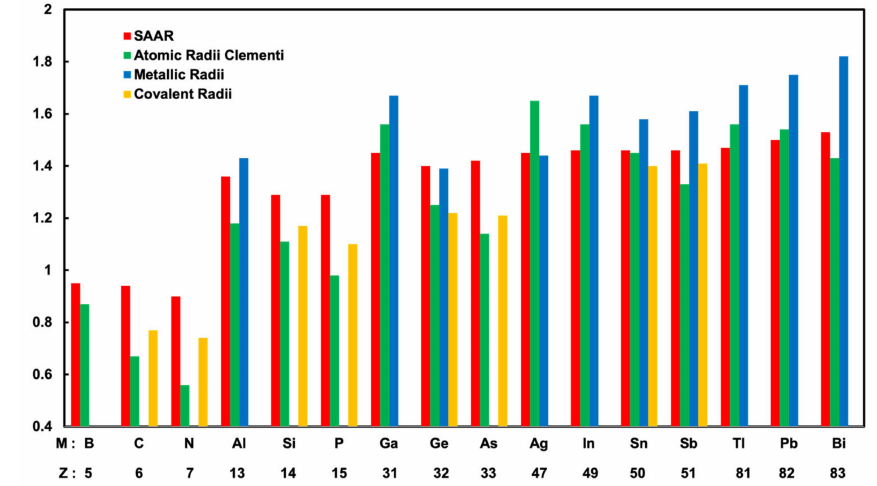
Figure 6. Summary of calculated atomic radii of surface alloy atomic radii (SAAR), Clementi’s atomic radii, metallic radii, and covalent radii, sorted by atomic number